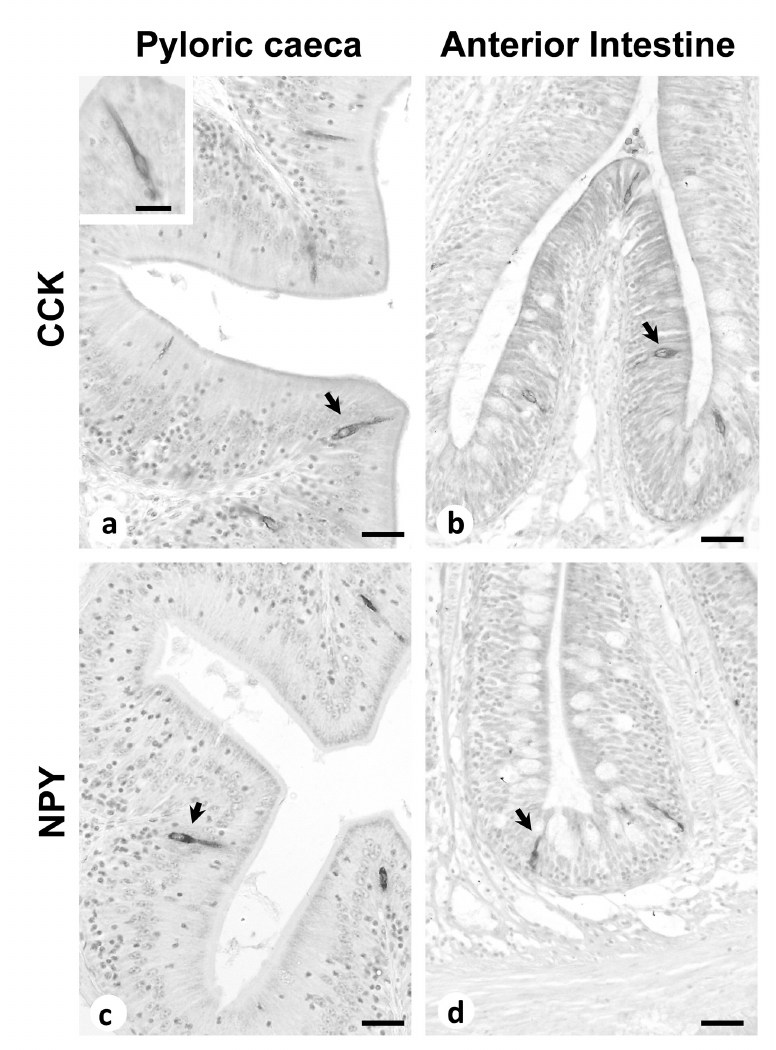
Figure 1. Photomicrograph of Prochilodus lineatus endocrine cells. – a and b. Open-type CCK-8- IR endocrine cells of the pyloric caeca and anterior intestine. – c and d. Open-type NPY- IR endocrine cells of the pyloric caeca and anterior intestine. Scale bars: low-power magnification views = 30 µm; insets = 10